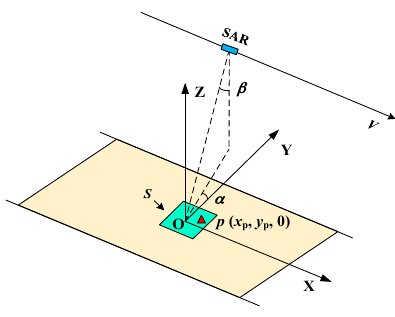
Figure 1. Geometry of the stripmap data acquisition.